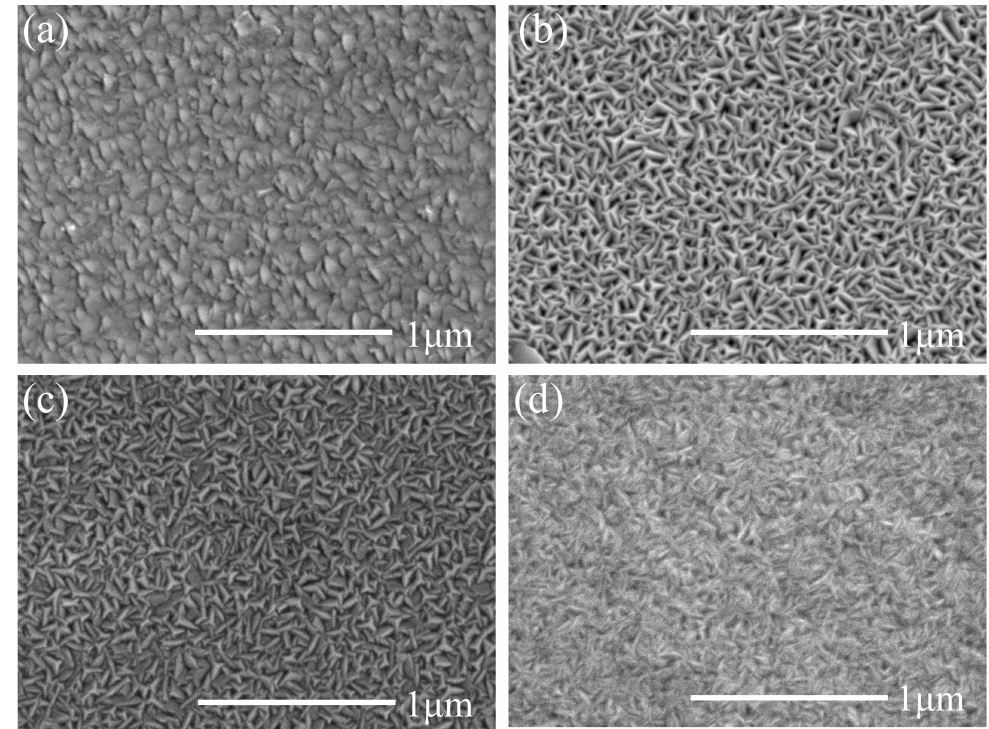
Figure 3. The SEM morphology of Mo film resulting from HiPIMS with different working pressures and conventional DC sputtering: ( a ) DC sputtering; ( b ) 3 mTorr; ( c ) 5 mTorr; ( d ) 7 mTorr.